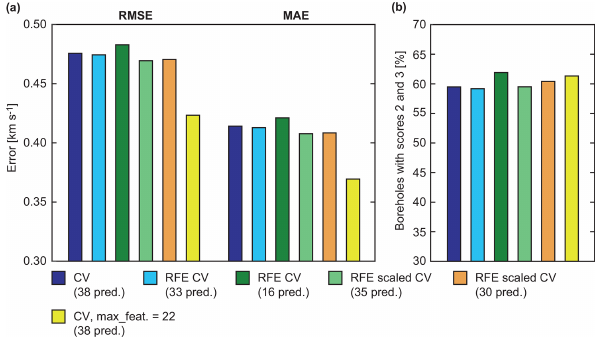
Figure 3. Comparison of (a) error metrics and (b) proportion of well-predicted boreholes (scores 2 and 3) for different model runs. RMSE: root mean square error; MAE: mean absolute error; CV: cross validation; RFE: recursive feature elimination.